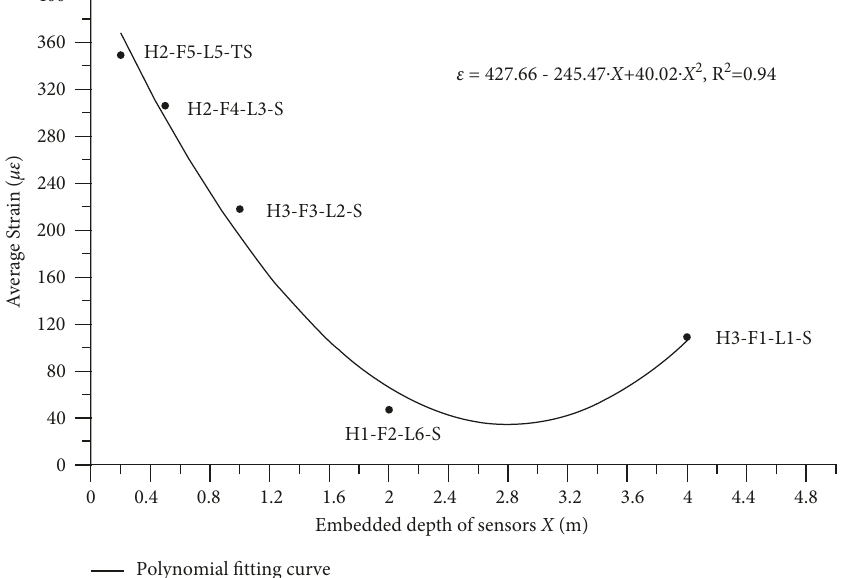
Figure 15: Relationship between the embedded depth of the sensors and the average strain of the